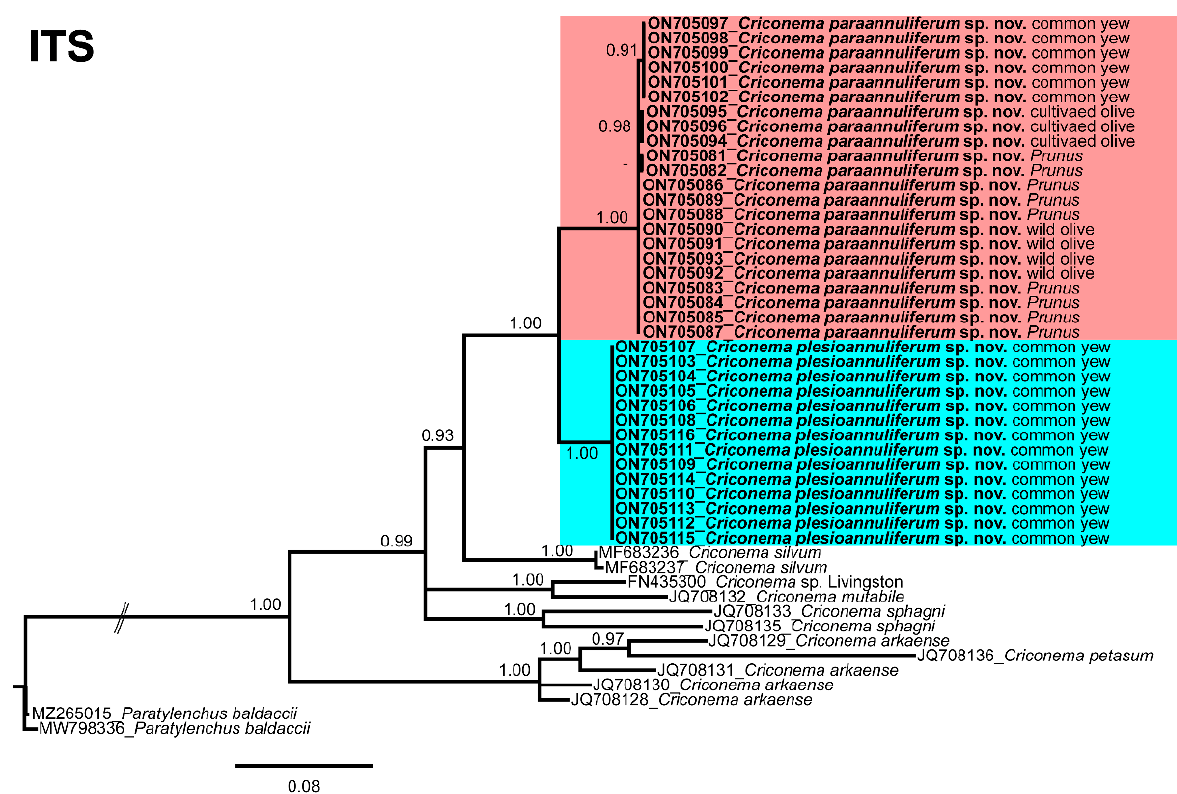
Figure 14. Phylogenetic relationships within the genus Criconema . Bayesian 50% majority rule consensus tree as inferred from the ITS rRNA sequence alignment under the transversion model with a gamma-shaped distribution (TVM + G). Posterior probabilities of more than 0.70 are given for appropriate clades. Newly obtained sequences in this study are in bold. The scale bar indicates expected changes per site, and the coloured boxes indicate the clade association of the Criconema annuliferum -complex.